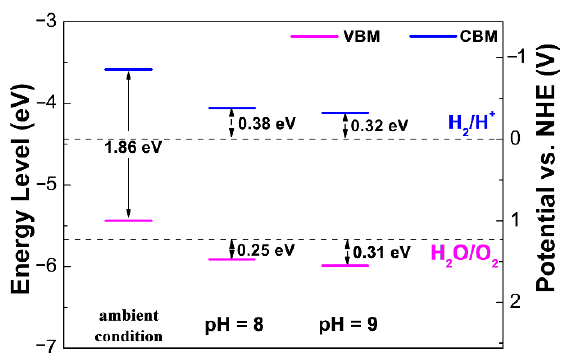
Figure 6. Band alignments with respect to water redox potentials of Sc 2 CF 2 in ambient conditions, pH = 8 solution, and pH = 9 solution.